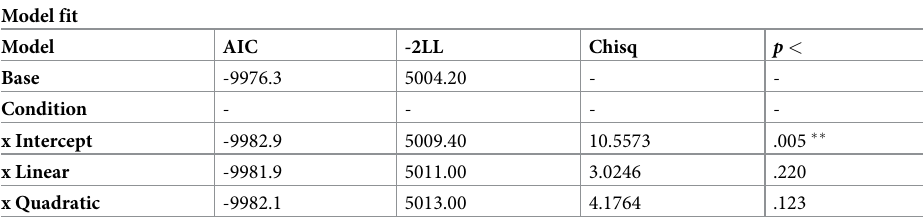
Table 3. Analysis of the goodness of fit of the model in the verb